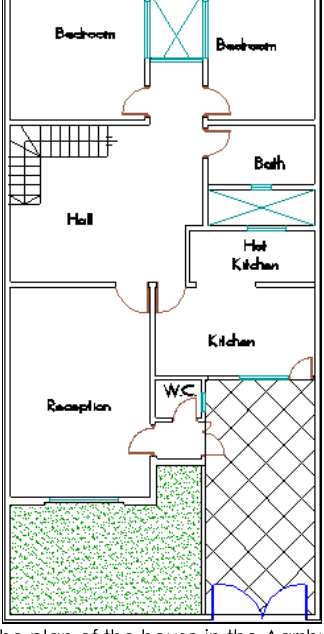
Figure 11. The plan of the house in the Aarshum Housing Project. (By Author) Factor number Twelve, found available through design analysis based on the similar observation for the first case study. See figure